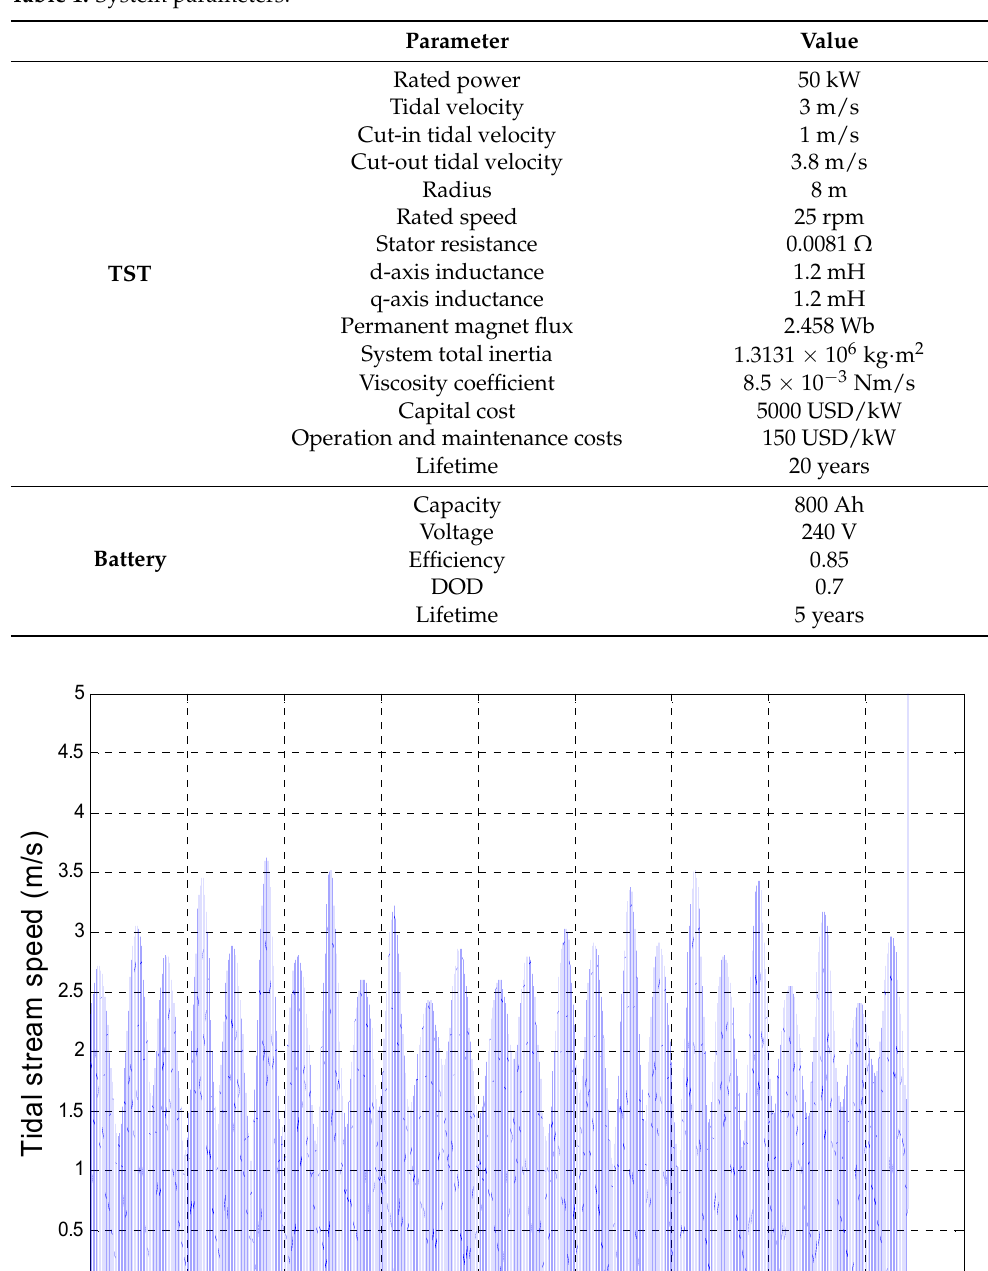
Table 1. System parameters.